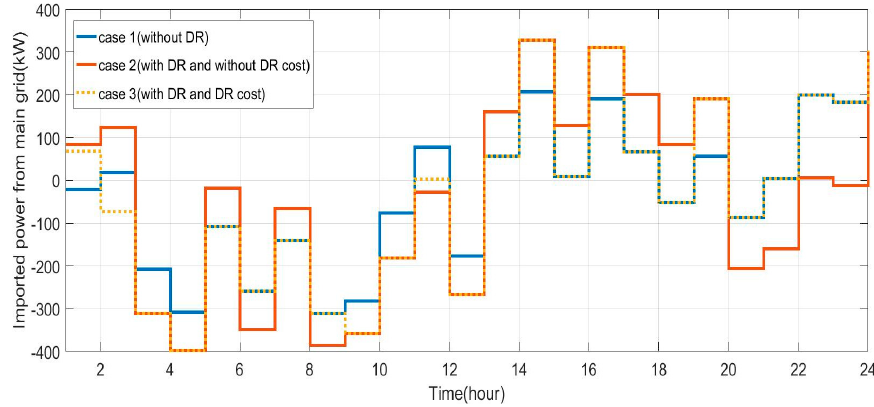
Figure 4. Transaction electrical power from the main grid in scenario 10.